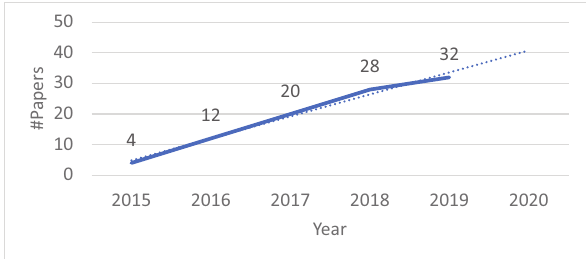
Figure 3. Number of papers per